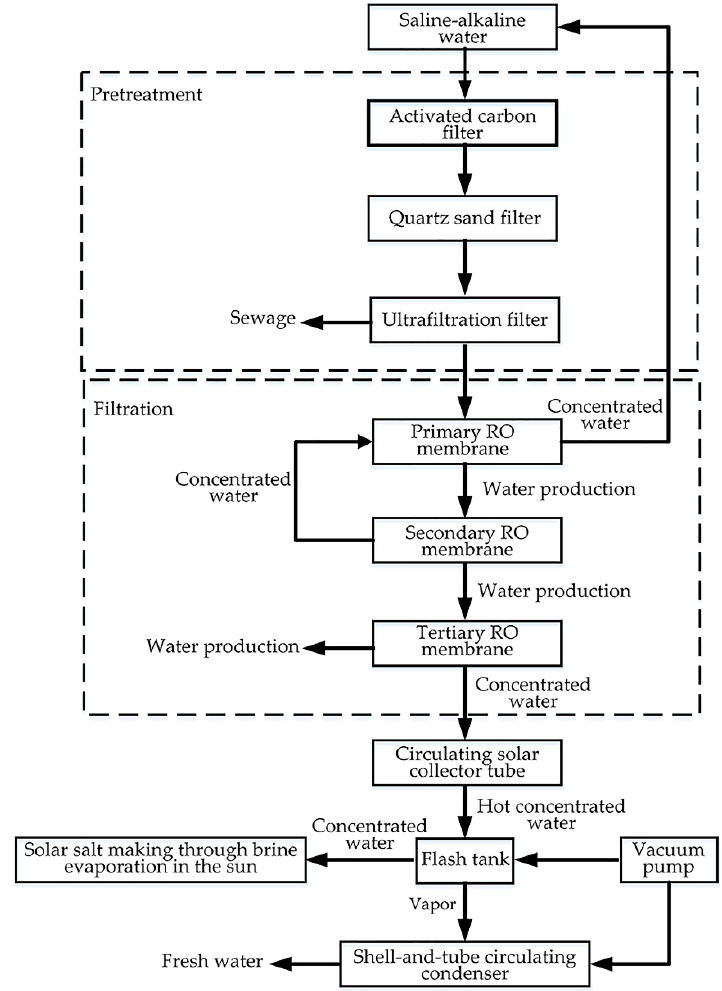
Figure 1. Process flow chart of farmland saline alkaline water separation and desalination.